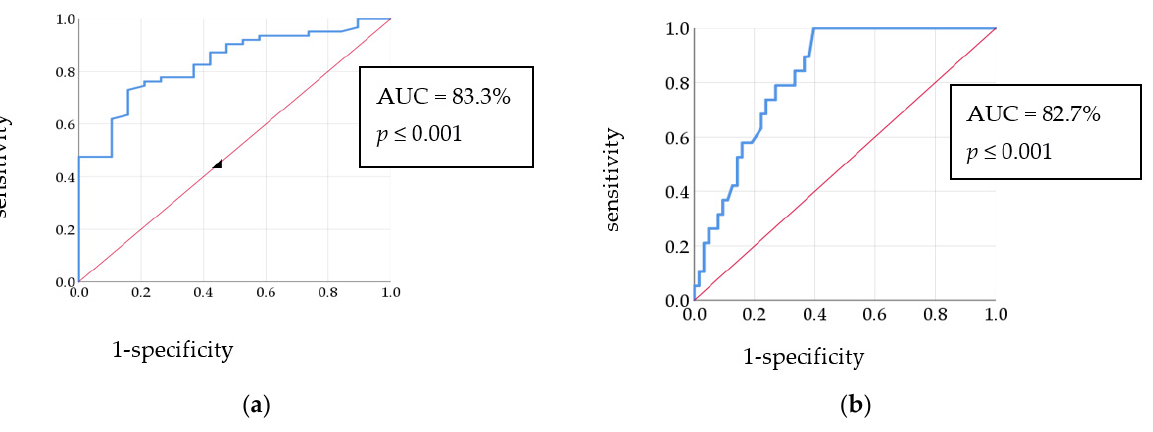
Figure 2. ( a ) ROC curve for the methylation% of MEFV gene exon2 in FMF patients and control Figure 3. Correlation of the MEFV exon 2 methylation% and the pyrin concentration among: group; ( b ) ROC curve for the pyrin level in FMF patients and control group. ( a ) controls; ( b ) FMF patients. Table 2. Relation of MEFV exon 2 methylation% and pyrin concentration with demographic data among FMF